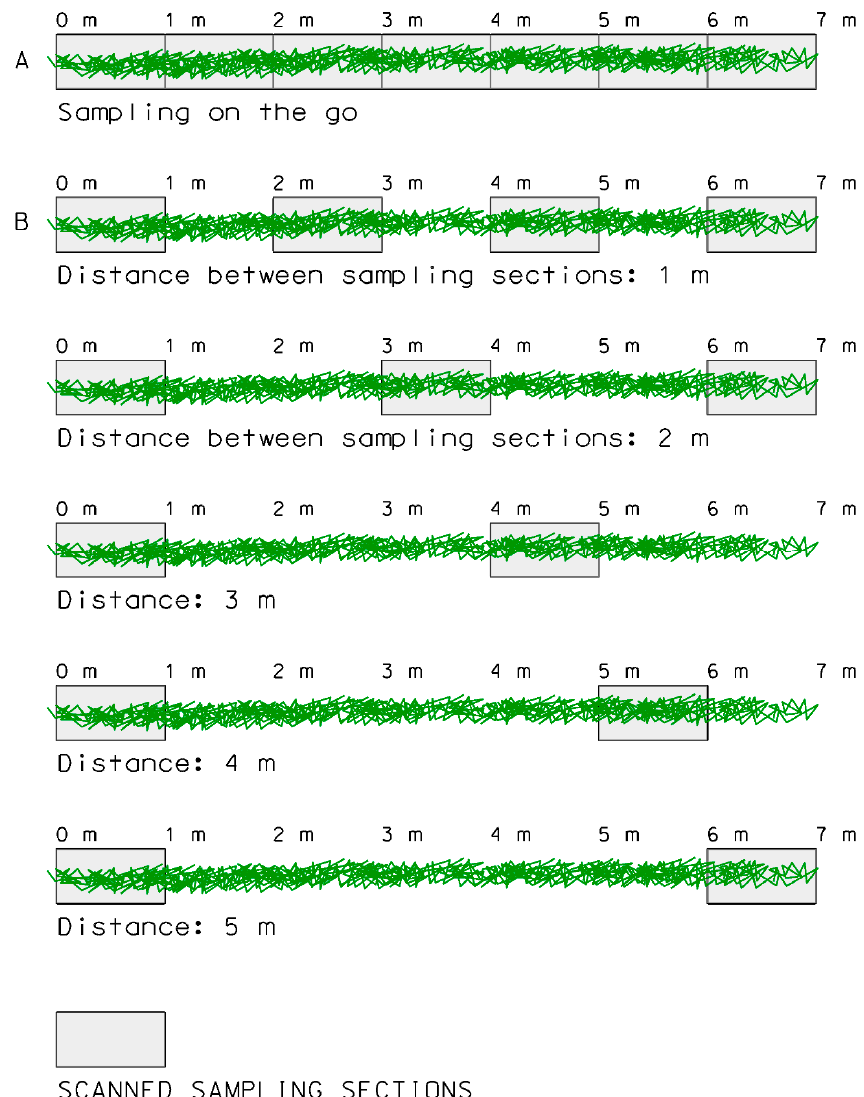
Figure 9. Different modes of operation of a MTLS along a row of vines. The rectangular area indicates the scanned sampling sections. ( A ) On-the-go scanning mode; ( B ) discontinuous scanning mode separating the sampling sections 1 m.